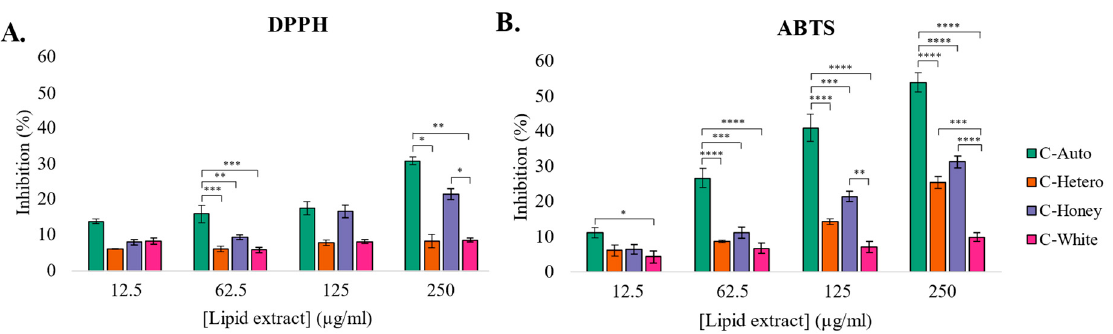
Figure 6. Antioxidant activity of C-Auto, C-Hetero, C-Honey, and C-White lipid extracts. Results expressed as percentage of inhibition induced by the concentration of lipid extract (µg mL − 1 ): ( A ) DPPH ● radical, ( B ) ABTS ● + radical. Data represented as means ± SD, n = 3. * q < 0.05, ** q < 0.01, *** q < 0.001 and **** q <